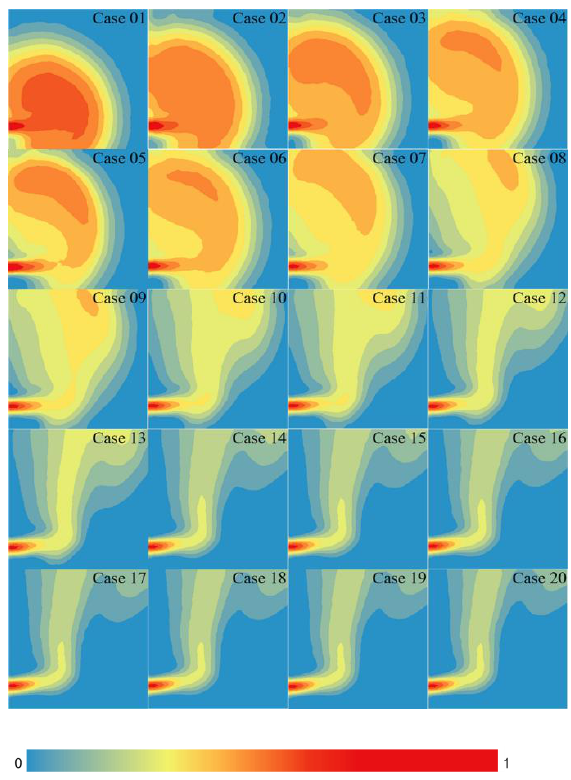
Figure 3. The normalized concentration field of the central plane under different conditions obtained by CFD model.